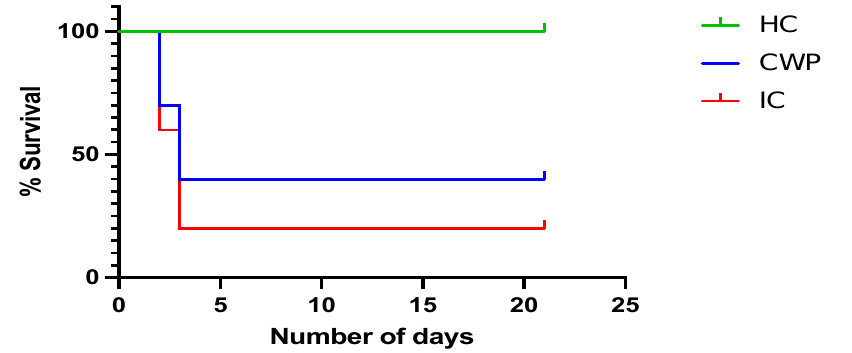
Figure 2. Survival probability of cell wall protein immunized BALB/c mice. The survival proportion states the potency of cell wall protein extract in protection against infection caused C. parapsilosis . CWP = cell wall protein; IC = infection control. p value < 0.005.